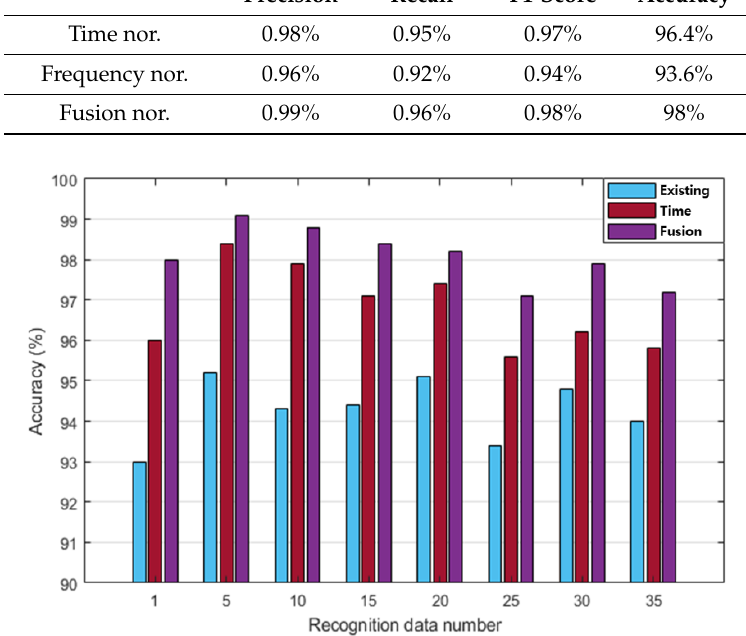
Figure 13. Comparative analysis of post-exercise ECG normalization recognition performance with increasing recognition data (existing, time, and fusion normalization method). Table 6. Performance comparison analysis using each normalization method.